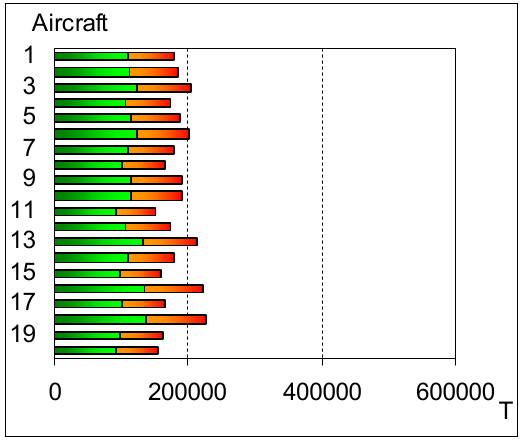
Fig 7. Bar chart of CUCDTP for the corroded specimens at 5%